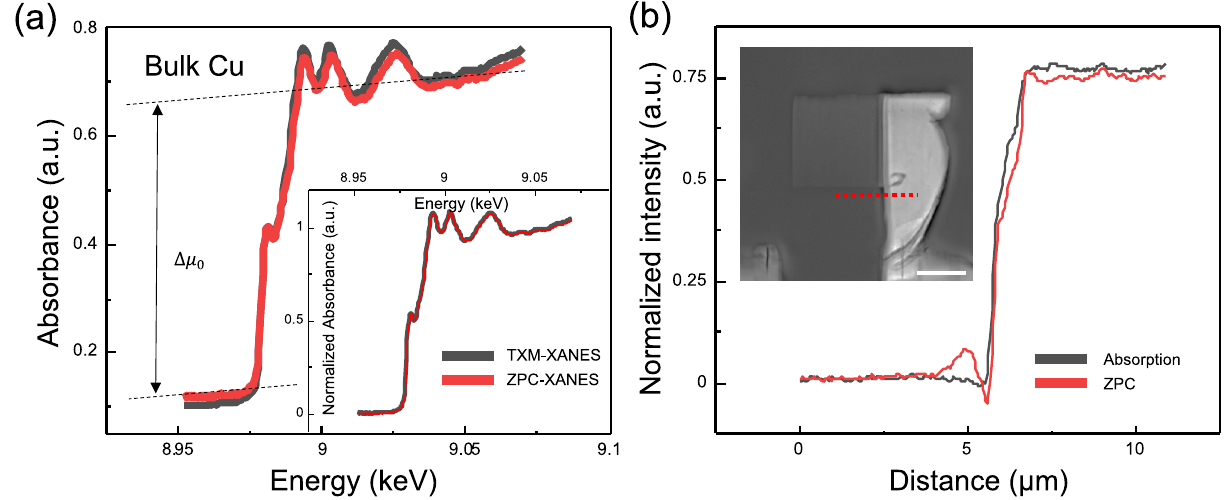
Figure 4. ZPC effects on XANES spectrum and TXM of bulk Cu. ( a ) XANES spectra of bulk Cu with 5 μm thickness. The normalized spectra are demonstrated in the inset. ( b ) Line profile of dotted line at the red line in the inset. The inset shows ZPC TXM at 9.030 keV with a scale bar of 5